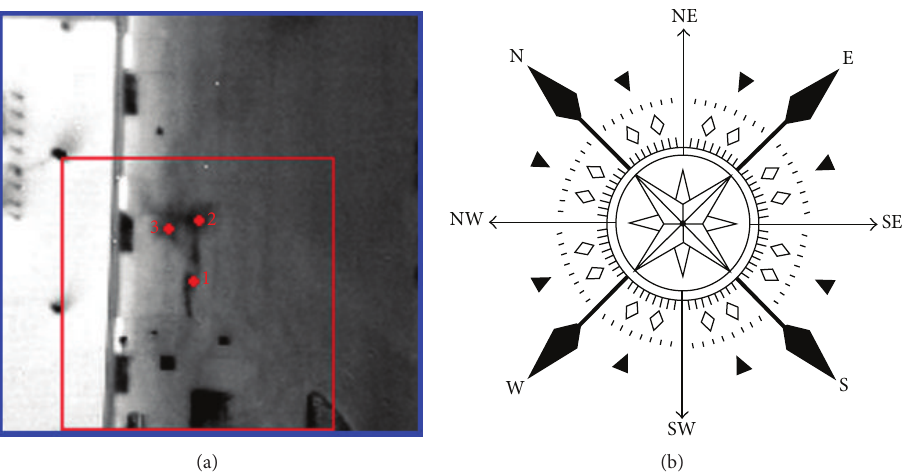
Figure 12: Illustration of subimage and pixels used in the background radiance estimation methods comparison.